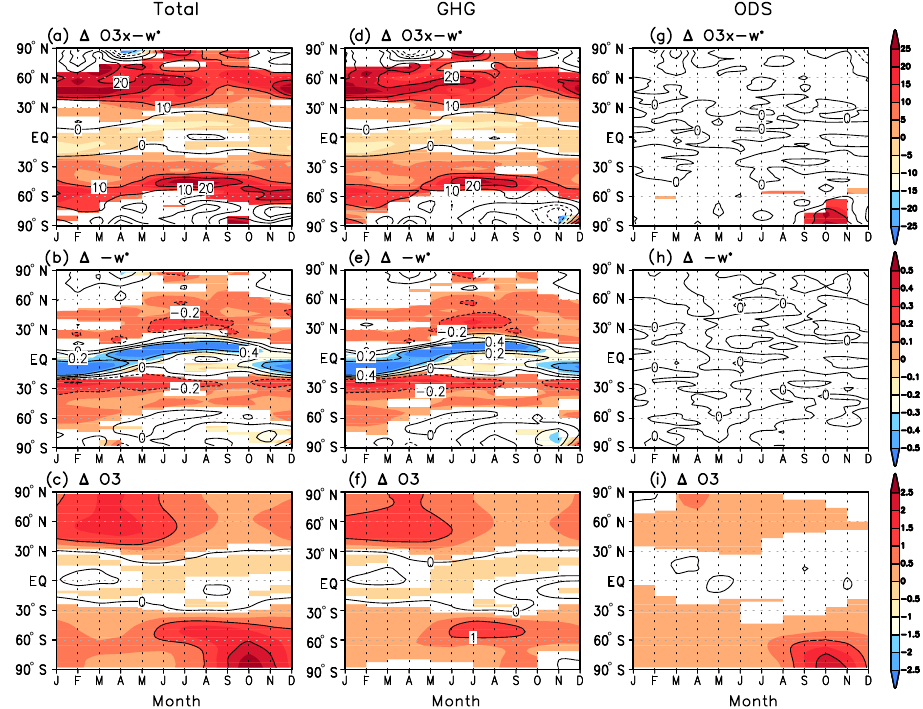
Figure 6. Annual cycle of the zonal mean change at 91hPa in the time-slice simulations due to all forcings between 2000 and 2100 (a–c) , due to GHG increase (d–f) , and due to ODS decrease (g–i) . (a, d, g) Changes in the product of ozone concentration and − w ∗ [10 6 gcm − 2 month − 1 ], which equals F in when integrated over all latitudes. (b, e, h) Changes in − w ∗ [mms − 1 ]. (c, f, i) Changes in the ozone concentration [moleculescm − 2 ]. Significant changes at the 95% confidence level are